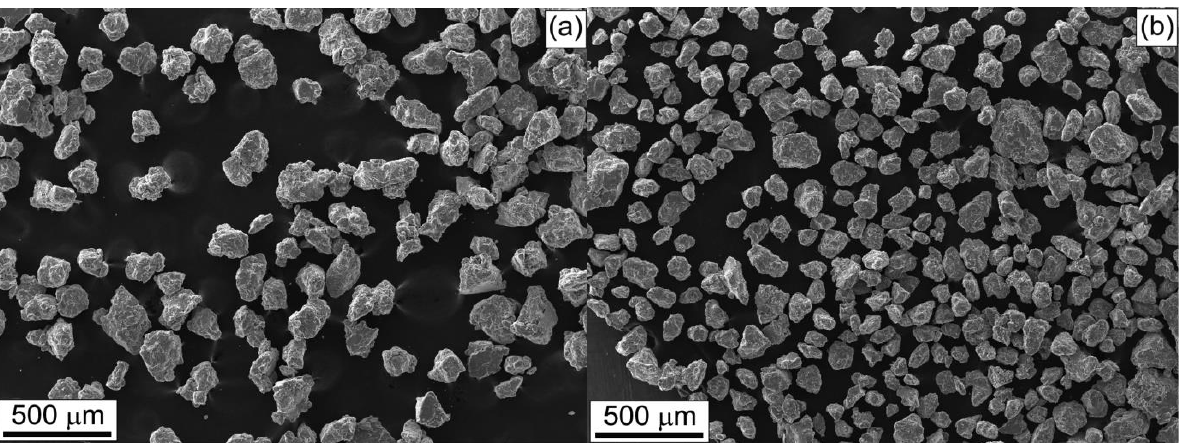
Figure 2. DSC curves of composite powders with additions of ( a ) 2% stearic acid and ( b ) 5% Cu.